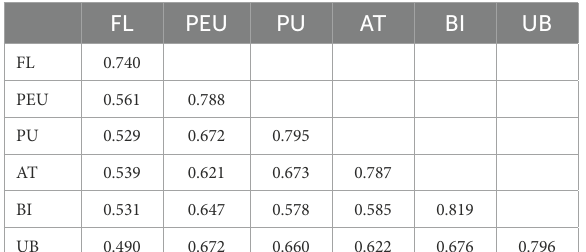
TABLE 9 Test of discriminant validity.